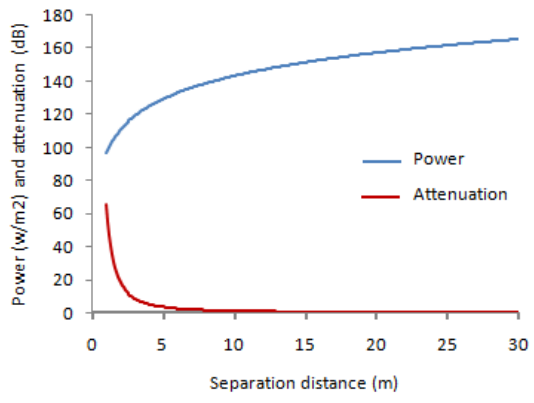
Figure 4. Relationship between power and attenuation vs. distance.